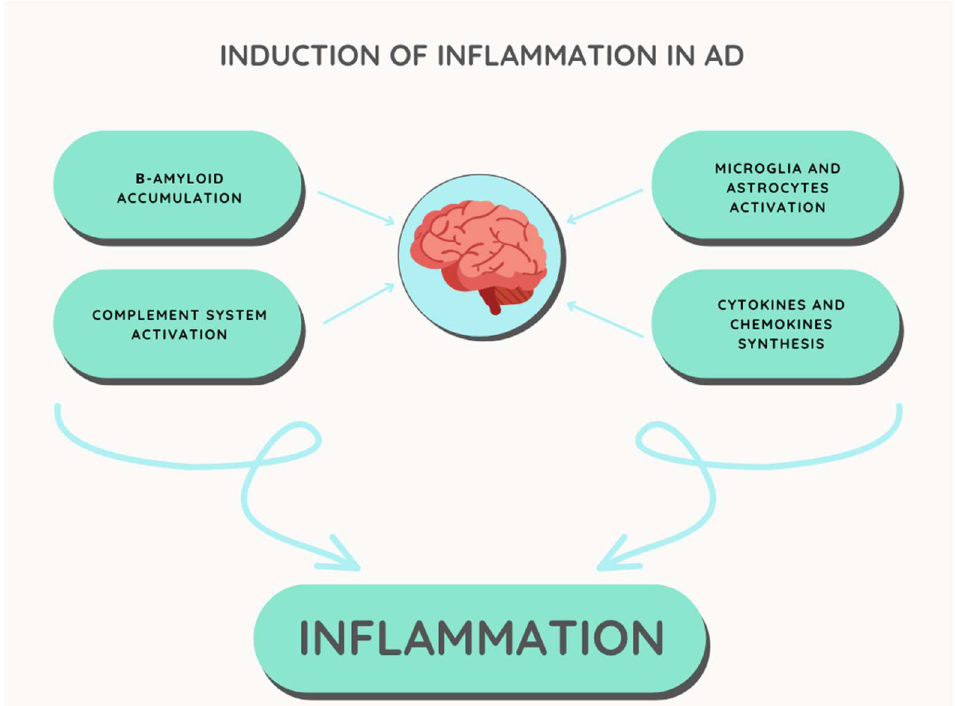
Figure 1. The primary inducers of inflammation in Alzheimer’s Disease.